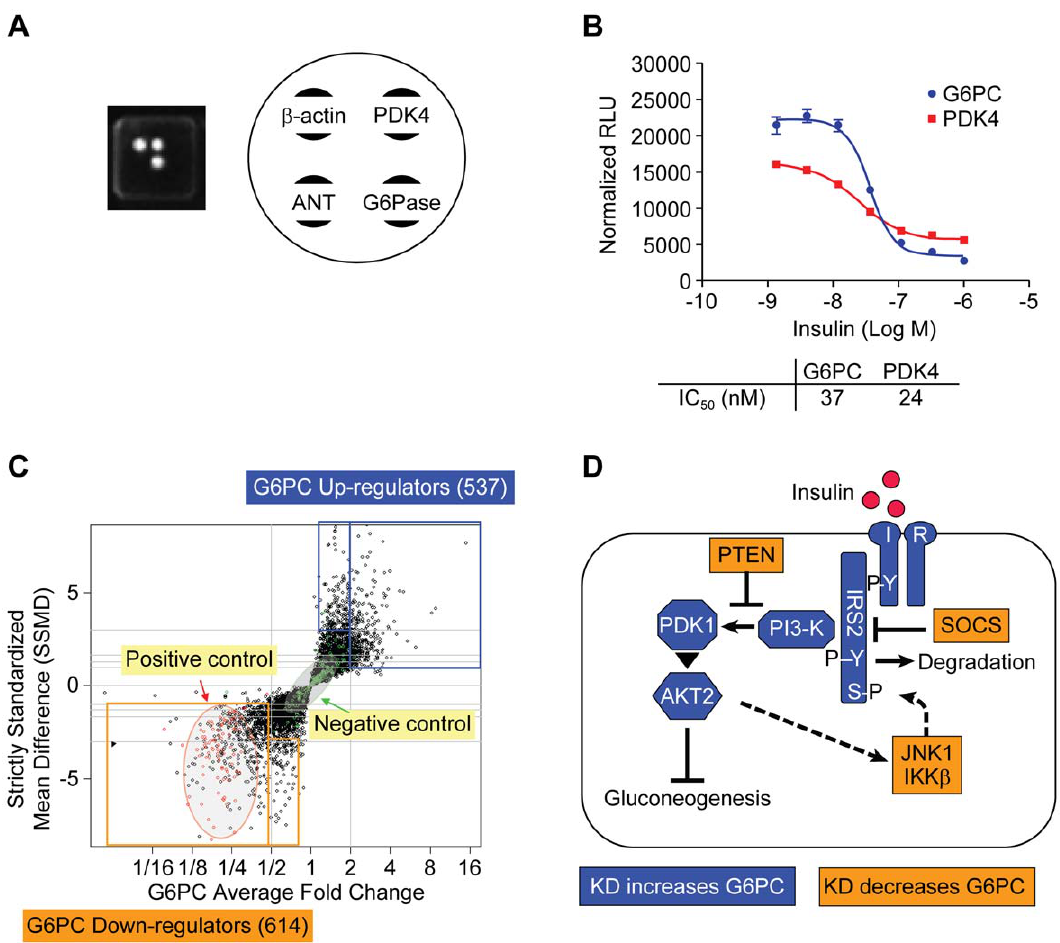
Figure 2. Screening of a druggable siRNA library with a 4-gene High-Throughput-Genomics (HTG) assay. A. Layout of genes within each well of a 4-gene HTG 384-well ArrayPlate. B. Insulin dose-responsively inhibits Dex/cAMP induction of G6PC and PDK4 mRNA expression in AH- G6PC cells when assayed by the HTG platform. Data are presented as the means 6 SEM of a study performed in triplicate; similar results were obtained in 4 independent experiments. C. Dual-flashlight plot comparing SSMD values vs. average fold change in G6PC mRNA expression by all siRNA pools in the library in order to select hits that regulate G6PC mRNA levels. Glucocorticoid receptor (GR) siRNAs were used as positive controls in each plates (red dots), while non-targeting siRNAs were used as negative controls in each plate (green dots). The blue square and the small rectangle represent the up-regulators with G6PC $ 2 and SSMD $ 1 and G6PC $ 1.3 and SSMD $ 2, respectively. The orange square and the small rectangle represent the down-regulators with G6PC # 1/2 and SSMD #2 1 and G6PC # 0.7 and SSMD #2 2, respectively. D. Major proximal molecular mediators and key negative modulators of hepatic insulin signaling. siRNA knockdown of target genes that lowered and increased G6PC mRNA expression are indicated in orange and blue,